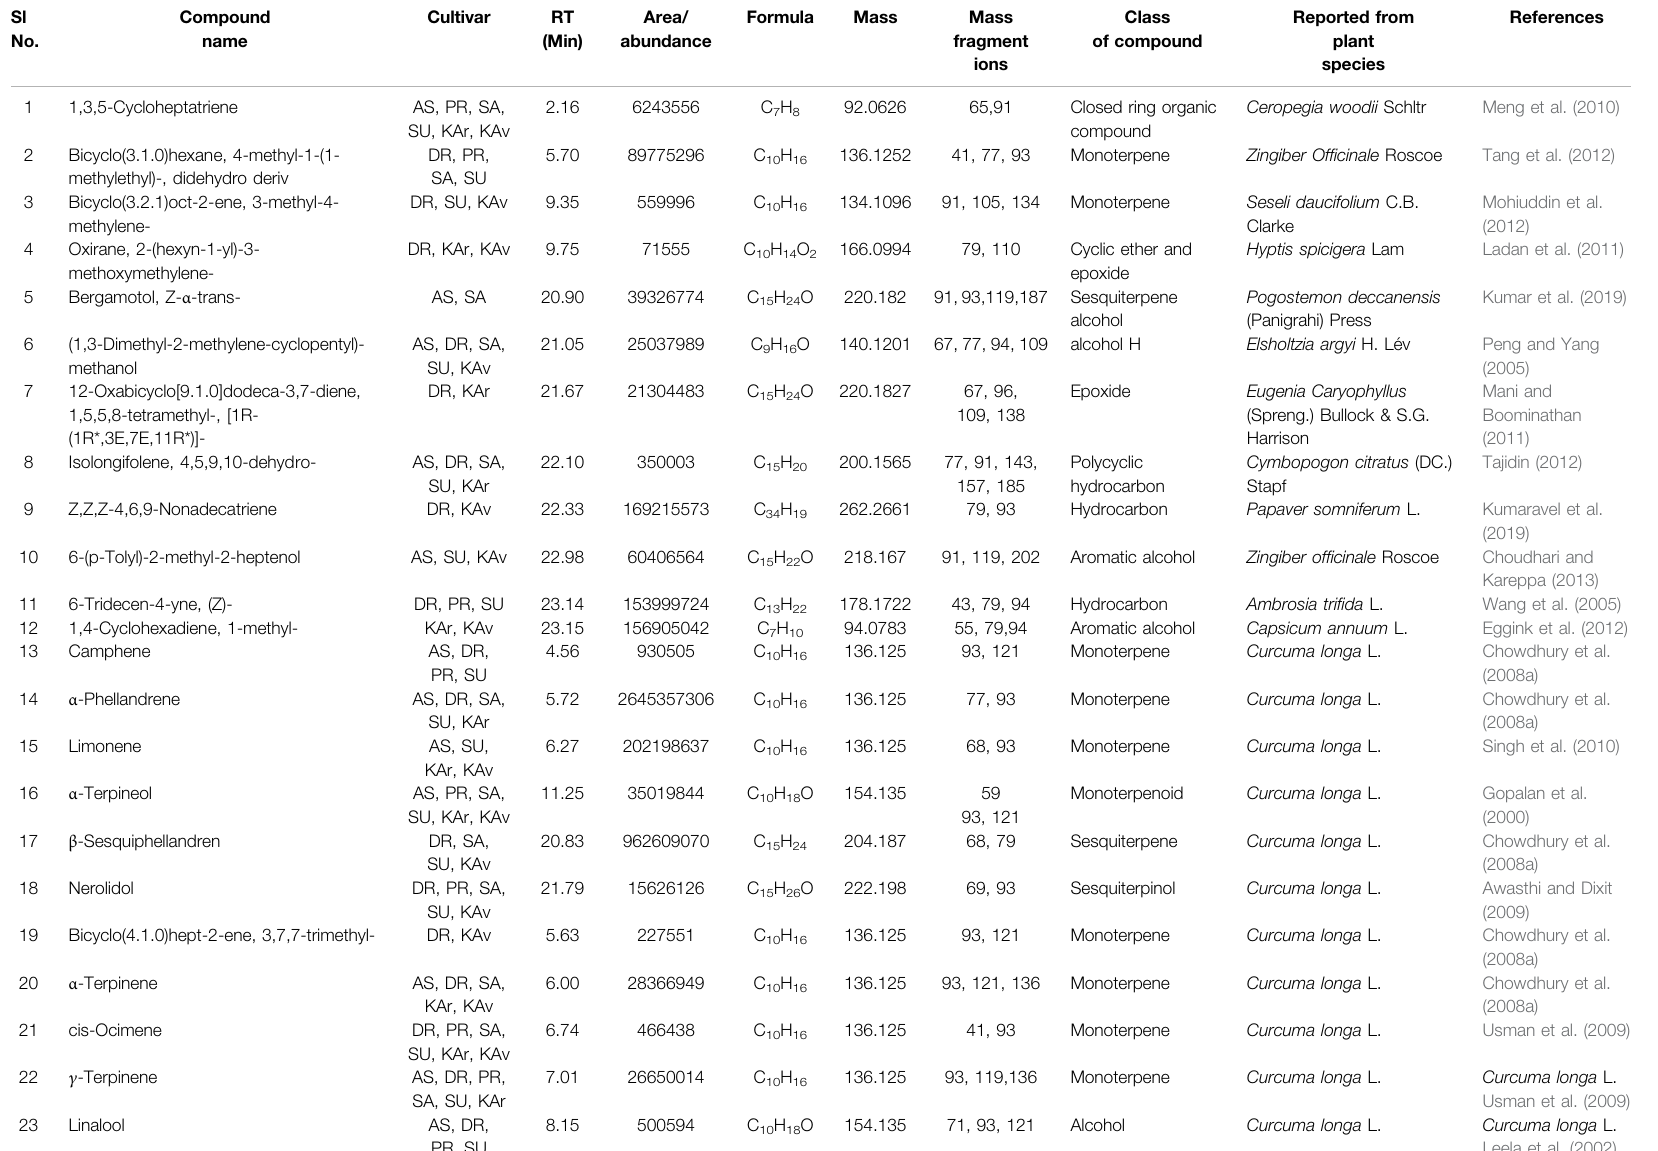
TABLE3| Compoundsdetectedinmorethanonecultivarof C.longa L.and C.aromatica Salisb.identi fi edbyGCMSintheessentialoilfromrhizomes.Thestructuresofthecompoundsfromserialnumbers1 – 12aregivenin Figure 2 (panel numbers: 24 – 35), and the compounds with Sl.No. 13 – 18 are shown in Figure 3 , with corresponding panel numbers: 8 – 13 respectively. Abbreviations used: AS, Alleppey Supreme; DR, Duggirala Red; PR, Prathibha; SA, Salem; SU, Suguna; KAr, Kasturi Araku; KAv, Kasturi